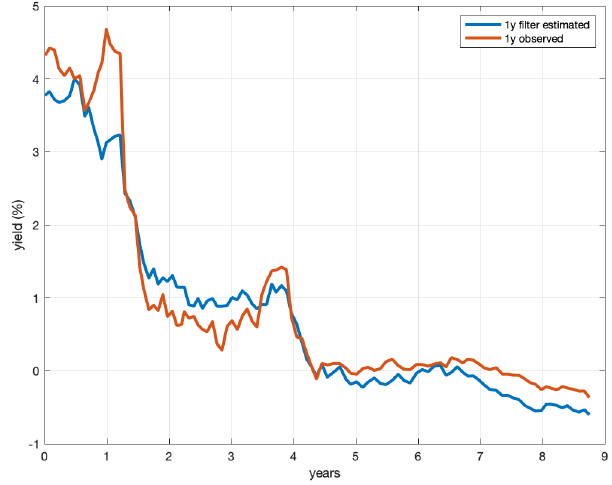
Figure 3. Comparison between the market yield rate (blue line) and the model − implied yield rate (red line) for the 1 − year maturity.